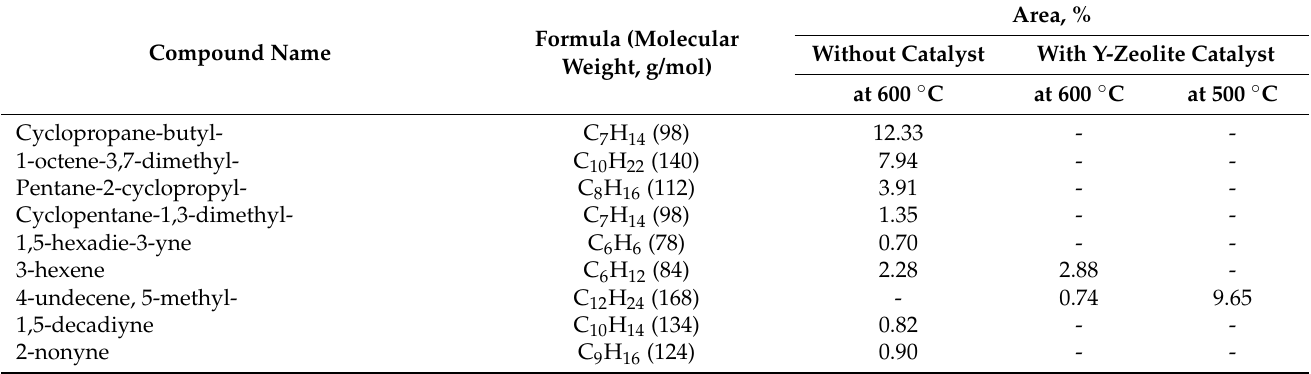
Table 4. Analysis of prescription medicine bottles using Py-GC/MS with and without Y-zeolite